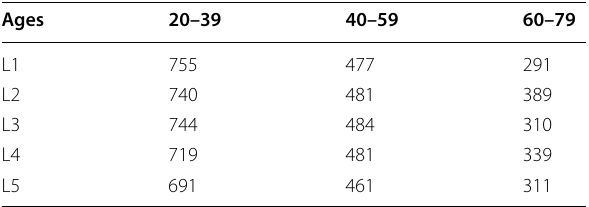
Table 5 Compressive strength (kg) for Japanese people [37]